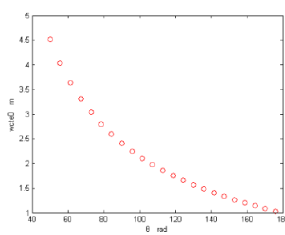
Fig.13 analysis of desired trajectory （ a ） - 4 Driver’s desired